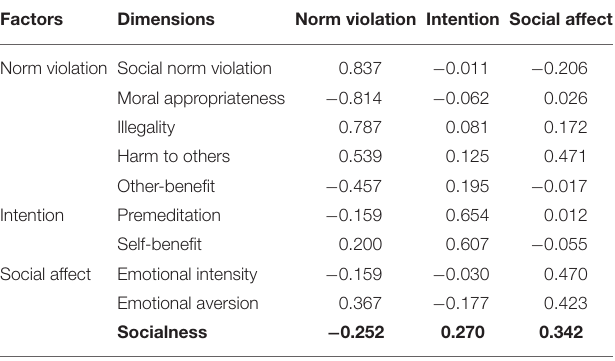
TABLE 2 | Results of the factors analysis for the three factors that were extracted through EFA method in America (based on Knutson et al.,